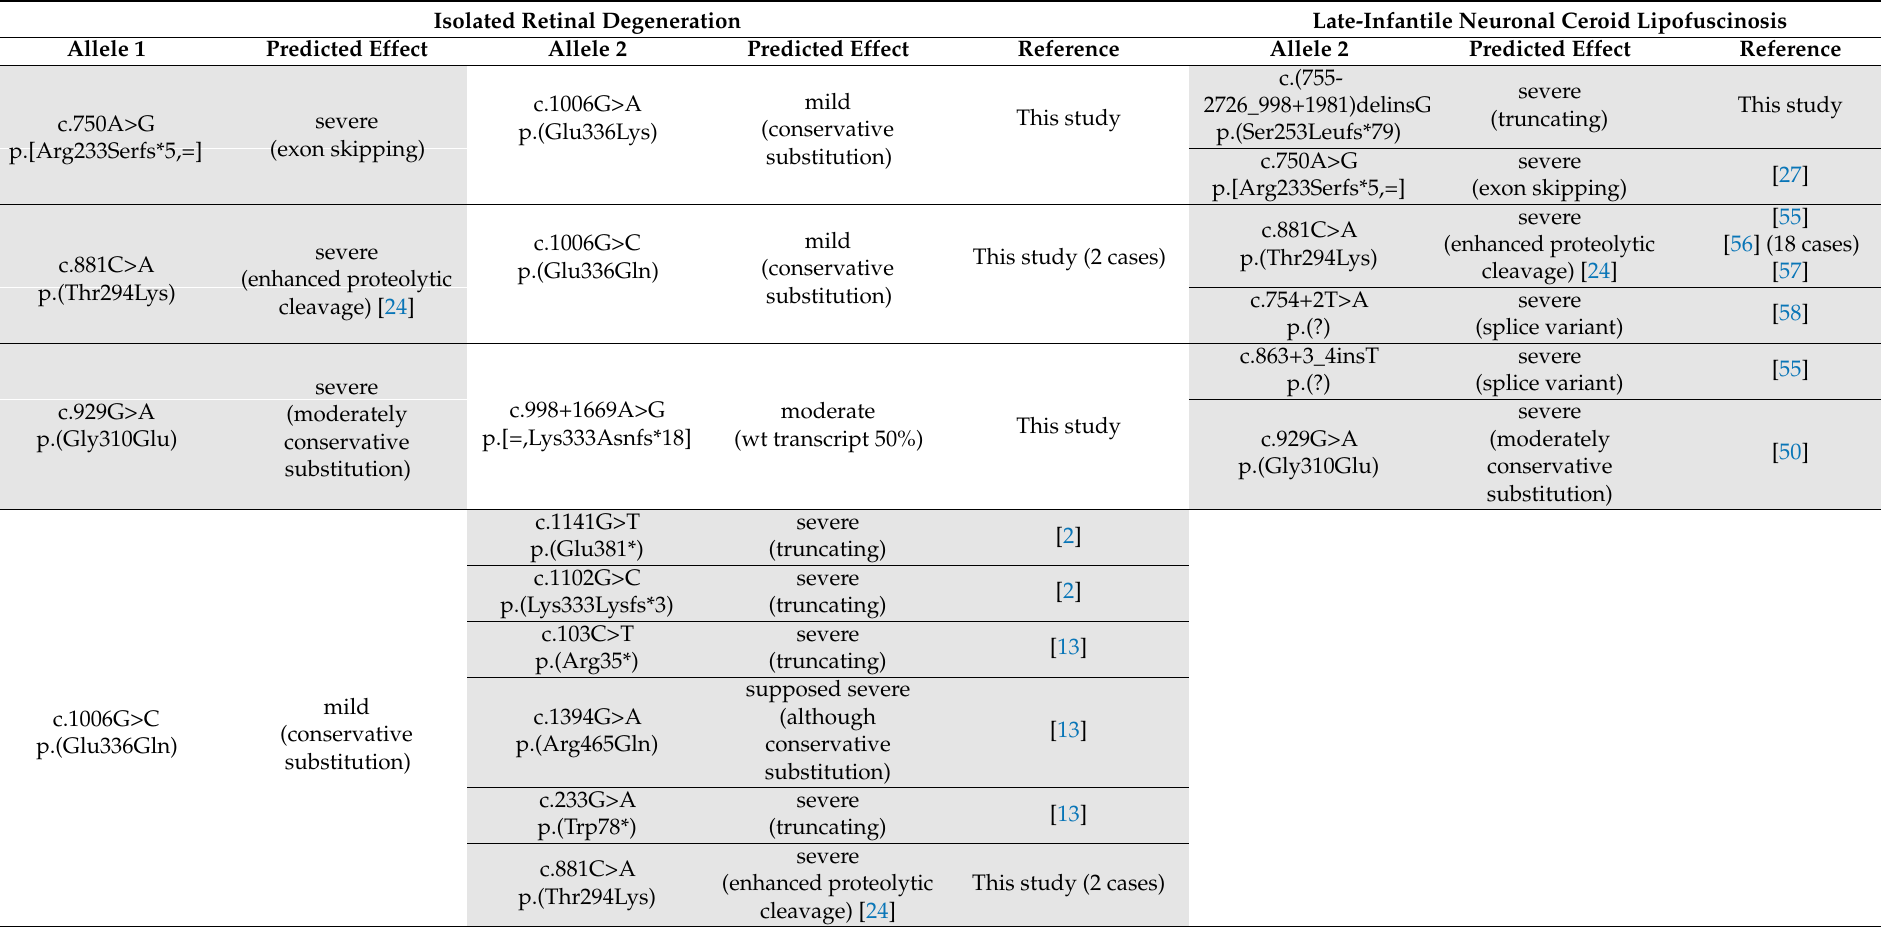
Table 3. MFSD8 variants found in both MD and NCL patients from literature